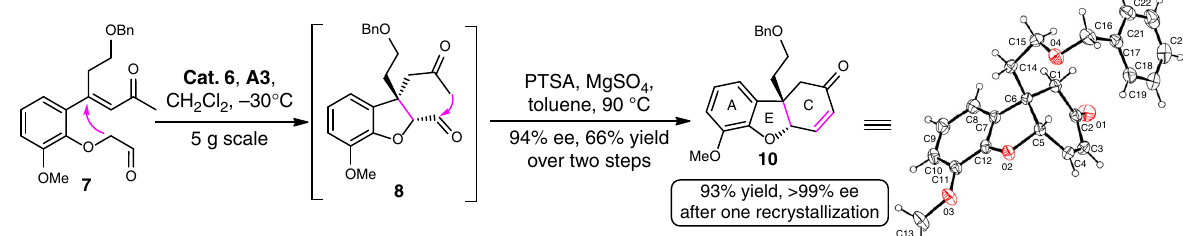
Fig. 4 Enantioselective Robinson annulation. The preparation of tricycle compound 10 and its X-ray crystal structure